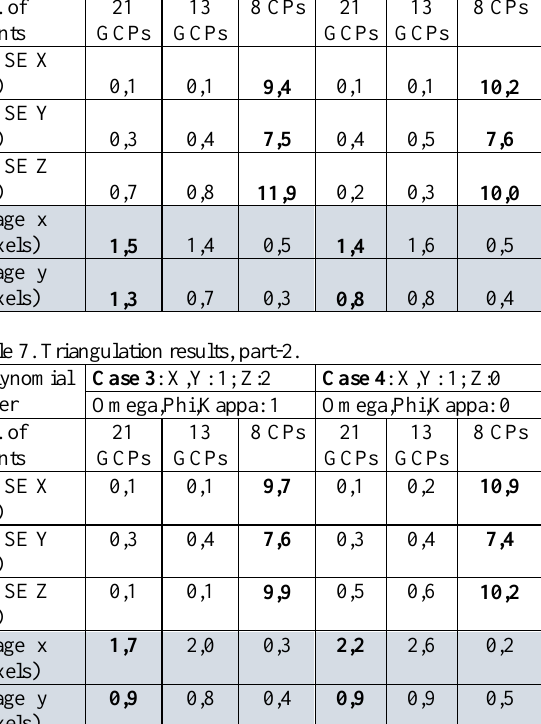
Figure 7. ESF and LSF analysis output in Quick MTF the edge sample in Figure 5 (left image).